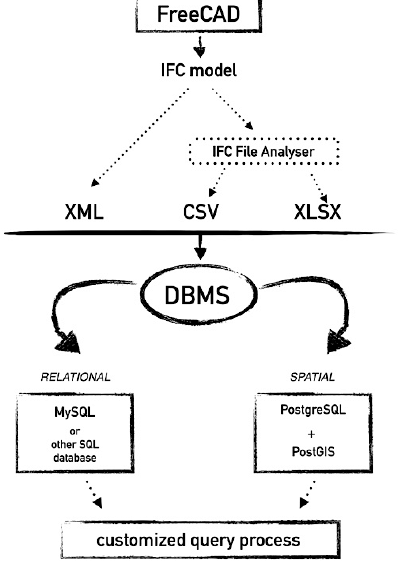
Figure 4. From IFC model created with FreeCAD to DBMS and query